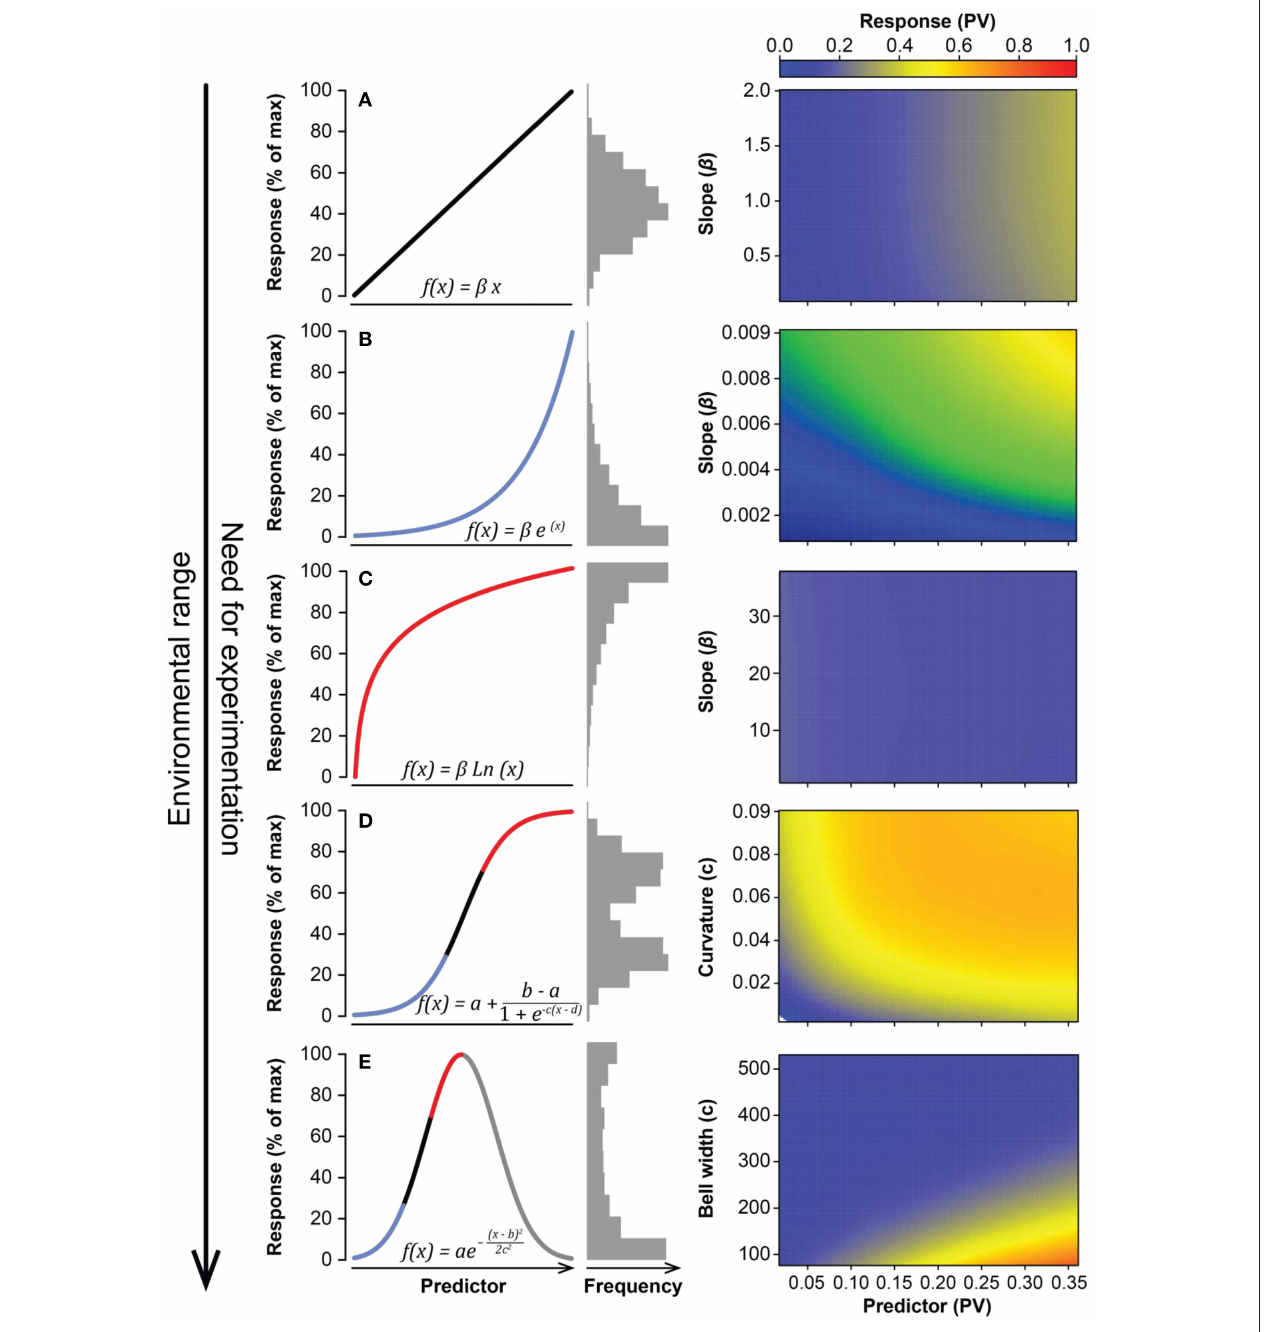
FIGURE 1 | Summary of theoretical responses of an ecosystem, or organism, variable as a function of an environmental predictor. Shown responses are, from narrow to wide environmental range of the environmental predictor, lineal (A) , exponential (B) , logarithmic (C) , sigmoidal (D) , and Gaussian (E) . Coloured lines represent the different types of responses within functions (blue, exponential growth; black, linear; red, logarithmic). Gray horizontal bars show the distribution of the response variable for each case. Boxes on the right side show the variation of the response variable (e.g., fruit production, color gradient) as a function of the variability of the predictor (e.g., weather) and the strength of the relationship between both variables for each of the theoretical responses. The variability of the response variable was estimated using the proportional variability index (PV, see Heath, 2006). Simulations performed with the coefficient of variation are shown in Figure S1. Blue colors indicate low values of variability (i.e., PV) and red colors indicate high values.